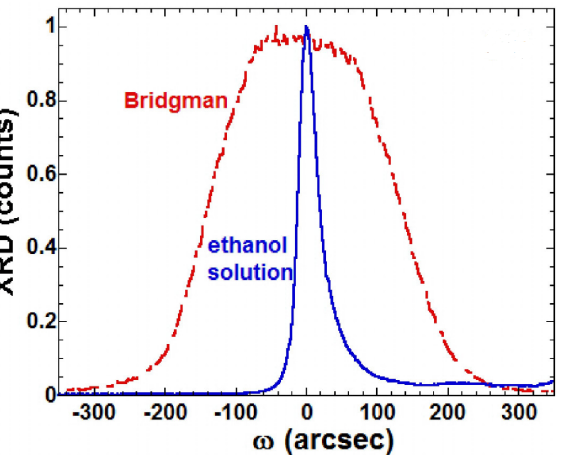
Figure 5. Comparison of rocking curve of BNA grown from the Bridgman and ethanol solution methods